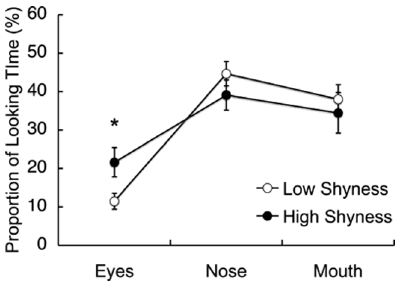
Figure 3. Infants’ visual preferences for different facial regions. This figure shows the mean percentile fixation durations for the following three types of facial regions: eyes, nose and mouth. The open and filled circles represent mean fixation durations for the infants with low and high shyness, respectively. *P , 0.05. Error bars indicate the S.E. of the